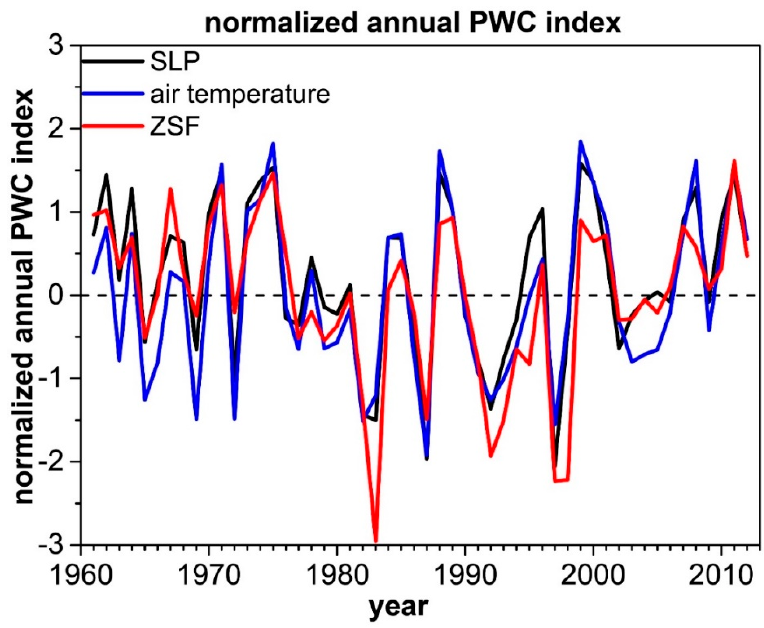
Figure 10. Time series (1961–2012) of the normalized annual mean tropical Pacific Walker circulation (PWC) intensity indices based on the SLP (defined as the mean SLP over the region (5 ◦ S–5 ◦ N, 80 ◦ W–160 ◦ W) minus the mean SLP over the region (5 ◦ S–5 ◦ N, 80 ◦ E–160 ◦ E); black line), air temperature (defined as in Equation (13); blue line), and ZSF (defined as the mean value of the inhomogeneous ZSF over the region (5 ◦ S–5 ◦ N, 120 ◦ W–160 ◦ W, 300–600 hPa); red